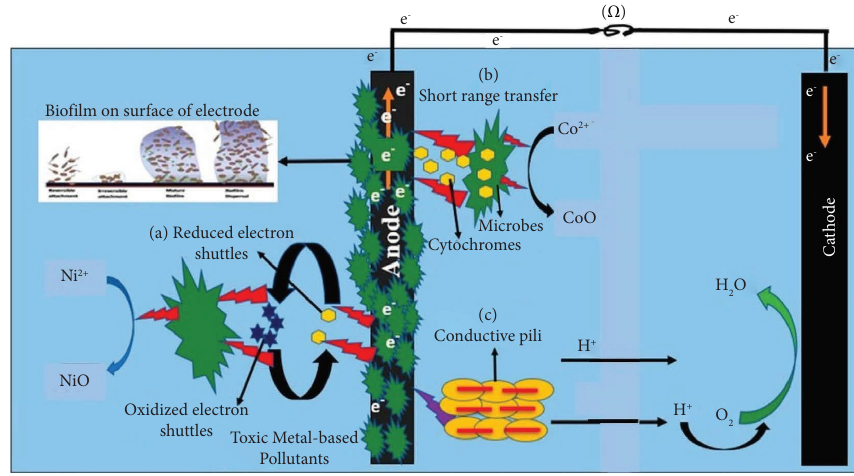
Figure 6: Mechanism of the present study (modifed from reference [35], open access MDPI publisher).